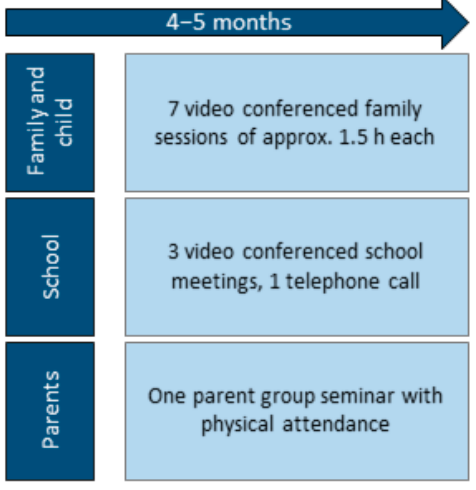
Figure 1. Overview of the intervention